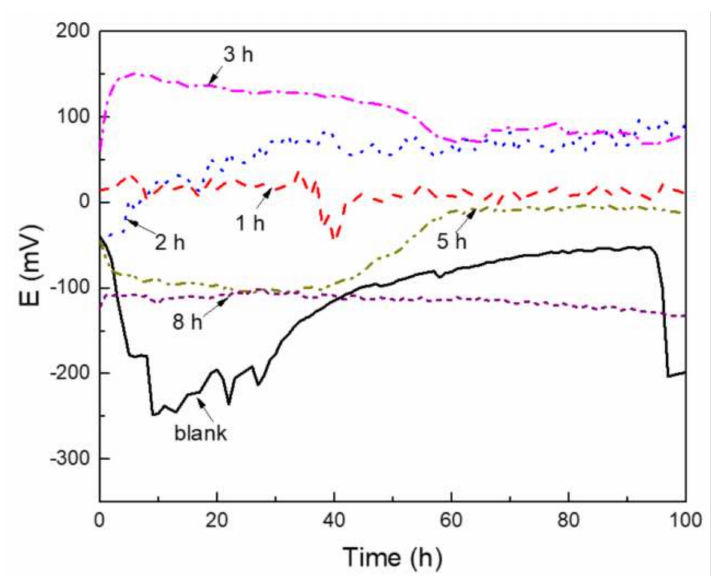
Figure 3. Effect of the oxidizing time on the E corr value for Ti6Al4V alloy corroded in artificial saliva